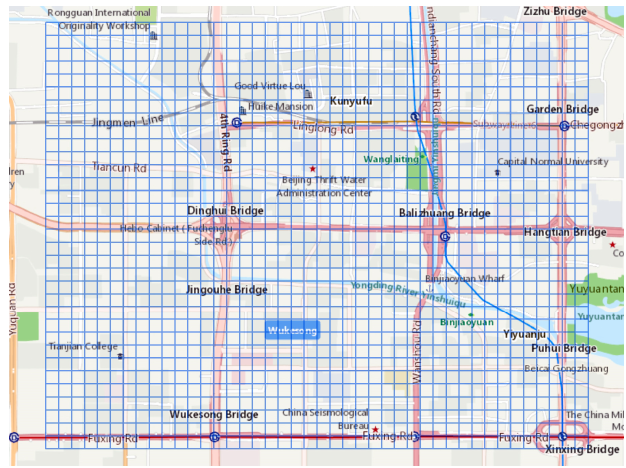
Figure 1. An example region is divided into squares with an equal area.